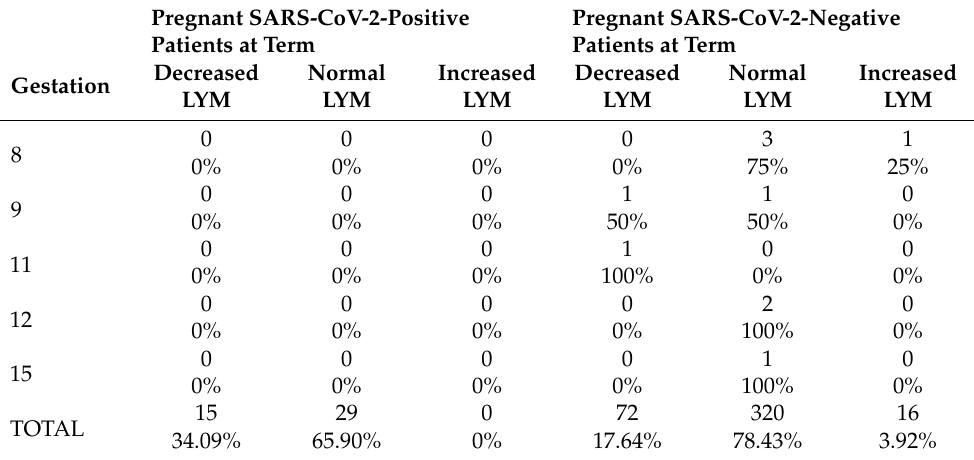
Table 7. Cont . Pregnant SARS-CoV-2-Positive Patients at Term Gestation